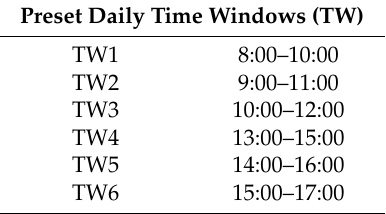
Table 1. Time windows